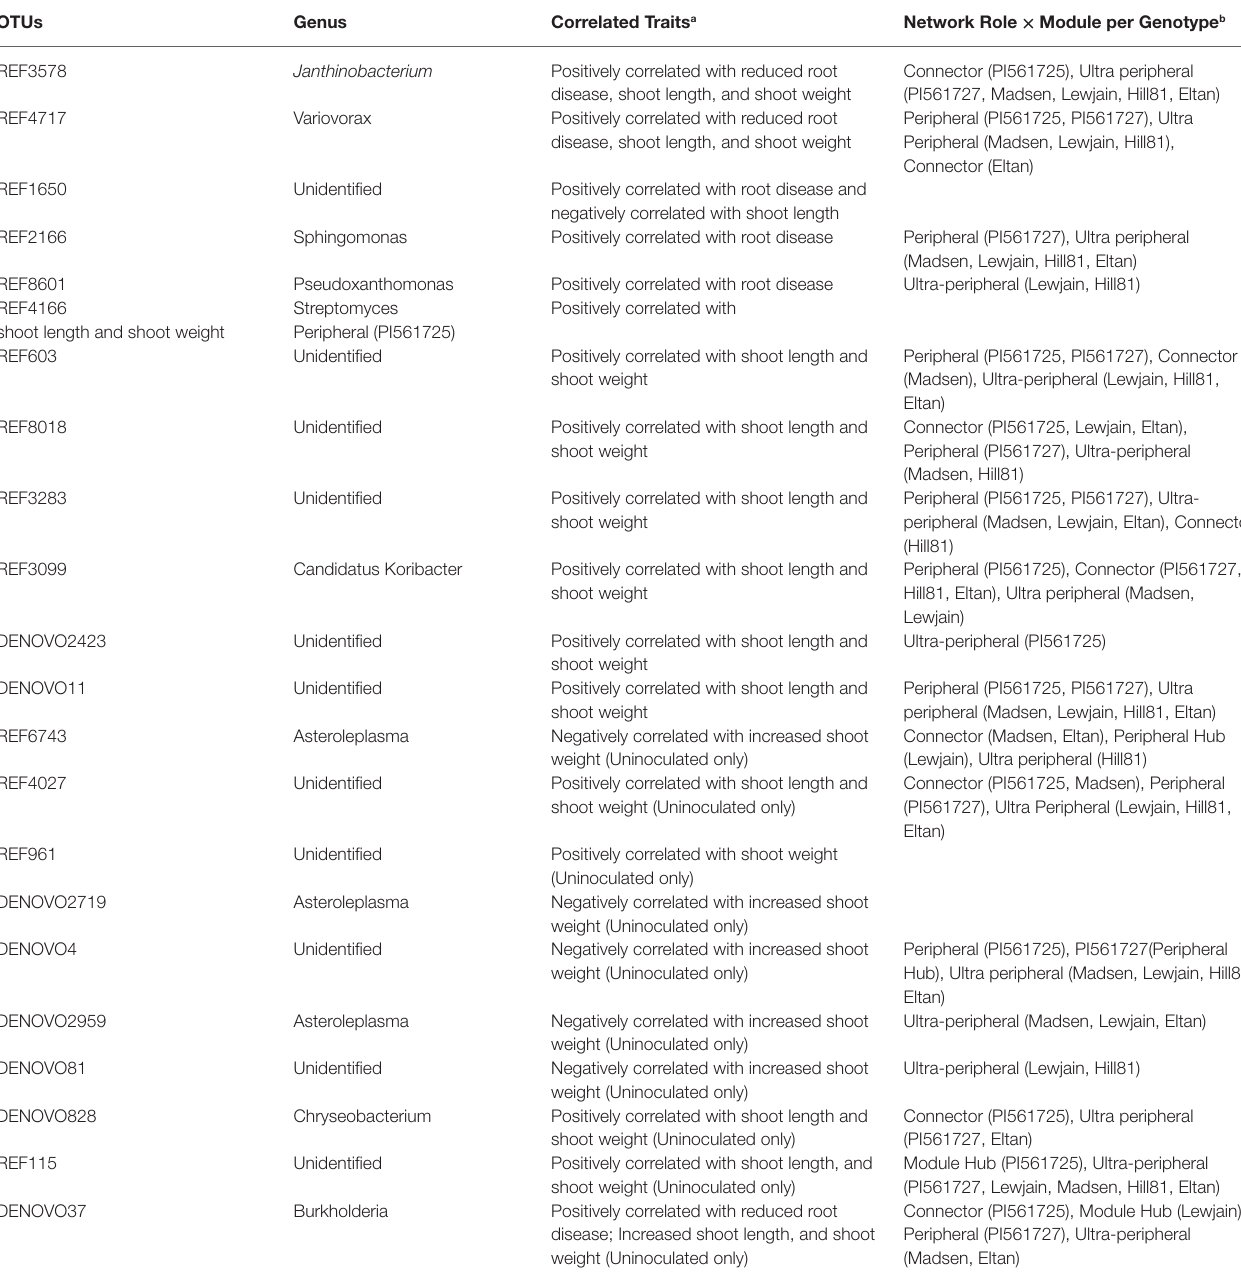
TABLE 2 | Differentially abundant OTUs correlated with traits in suppression assays and with relevant network roles.